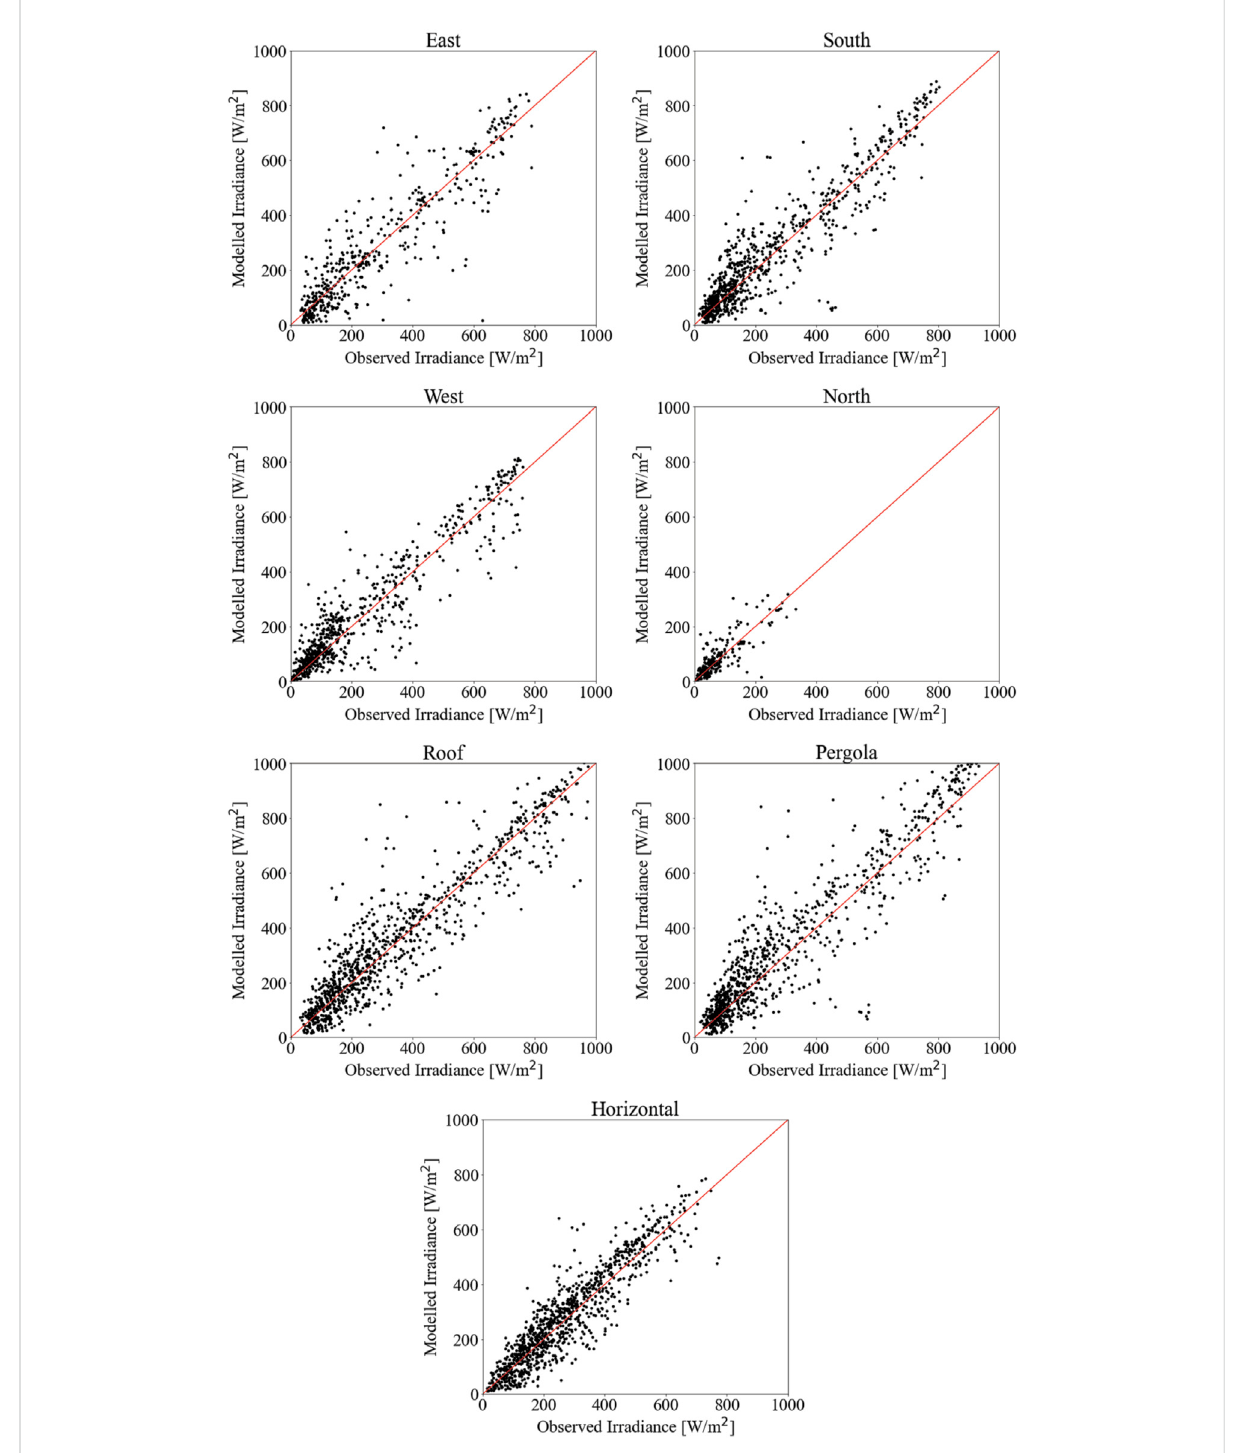
FIGURE 10 Scatter plots with solar irradiation outcomes from the numerical model against the experimental